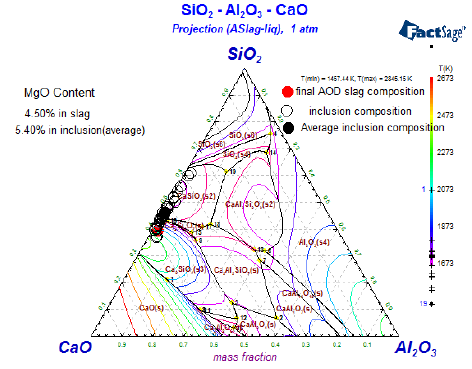
Figure 5. Chemical composition of inclusions and slag at the final stage of the AOD process.